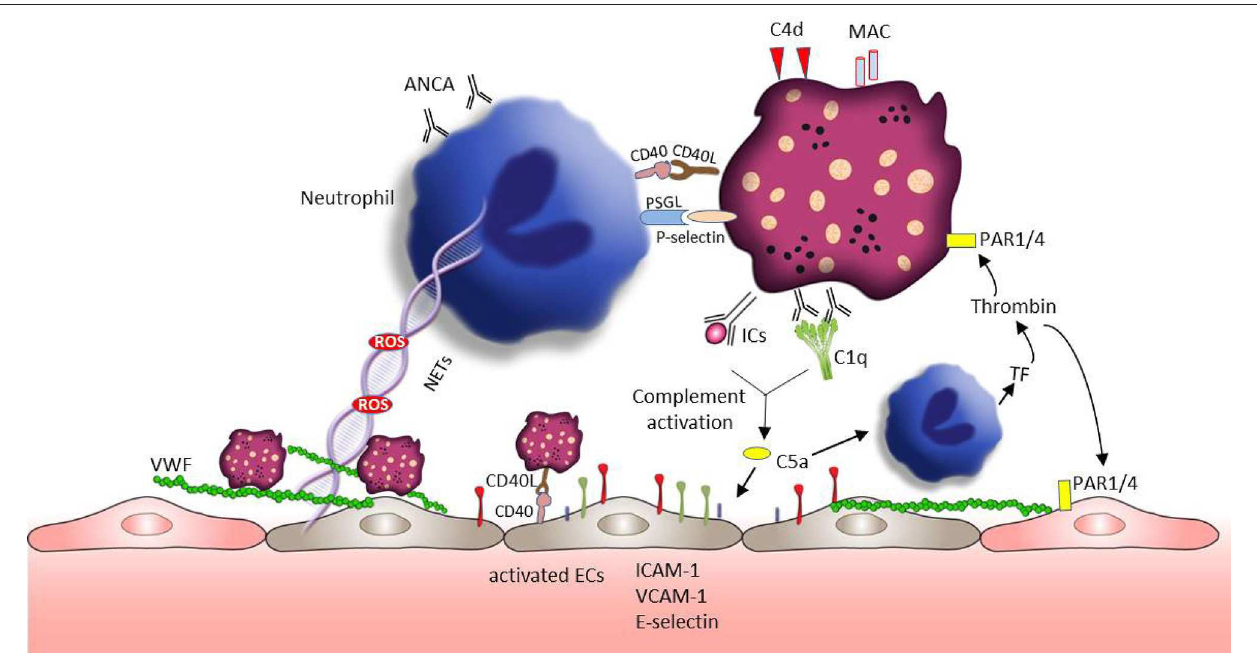
FIGURE 4 | Platelets involvement in the pathogenesis of AAVs. Neutrophils play a crucial role in the development of AAVs. Platelet receptors CD40L and P-selectin enable the interaction with neutrophils promoting ROS generation and NET formation. ROS and NETs are toxic to the endothelium and can lead to VWF release and vascular injury. VWF is well-known to mediate platelets adhesion and aggregation. Similar to neutrophils, sCD40L-CD40 can also mediate platelet -endothelial cell interaction, which can enhance the expression of endothelial cell adhesion proteins (e.g., E-selectin, VCAM-1, and ICAM-1). C5a, a chemoattractant anaphylatoxin, can directly attract and activate neutrophils promoting the exposure of tissue factor. Tissue factor initiates the plasmatic coagulation which culminates in the generation of thrombin. Thrombin is able to further activate platelets and endothelial cells through PAR signaling pathway, followed by platelet degranulation and VWF release. In addition, C5a can also directly active endothelial cells accelerating vascular